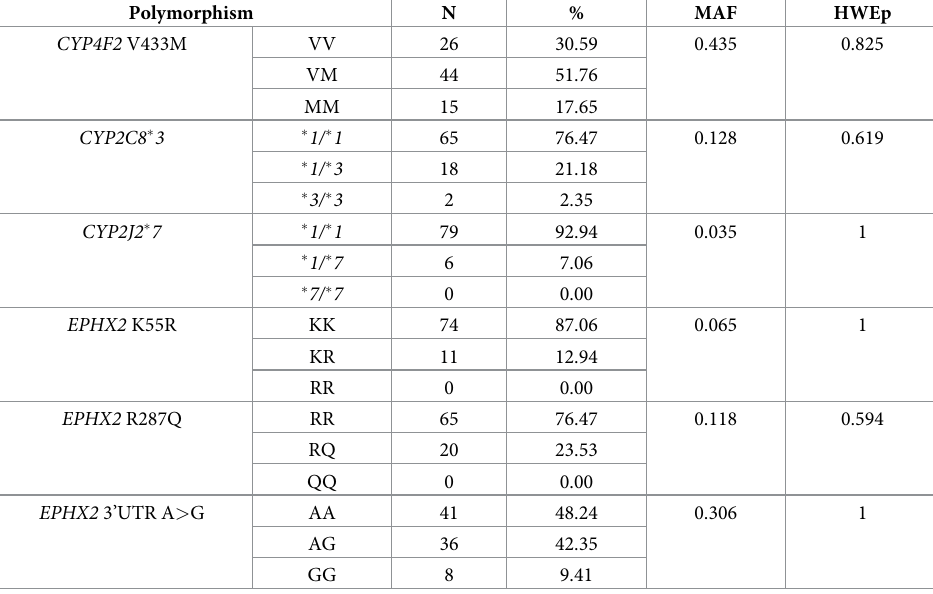
Table 2. Genotypic and allelic frequencies in the 85 kidney